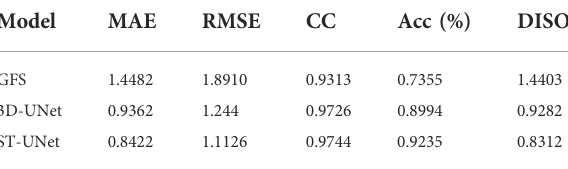
TABLE 6 The performance of temporal downscaling for 2-m temperature on the test set. Model